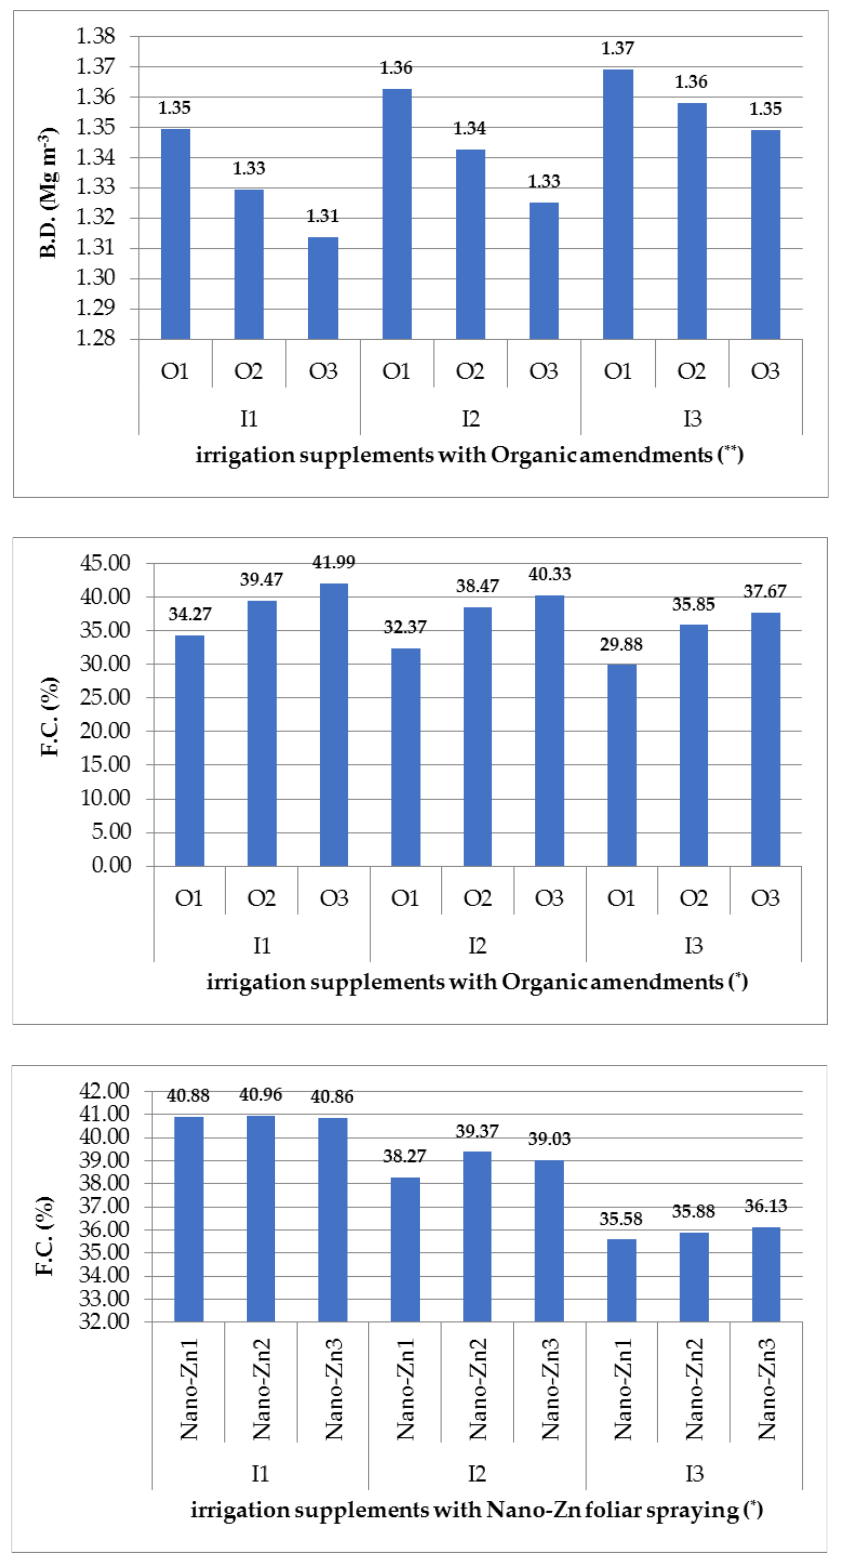
Figure 7. The combined effect of different treatments (irrigation supplements, organic amendments, and nano-Zn foliar spraying (average data over the two seasons) on soil bulk density (BD, Mg m −1 ) and field capacity (FC, %). The (*): refers to significant, and (**): refers to highly significant differences between them ( p < 0.05, 0.01).